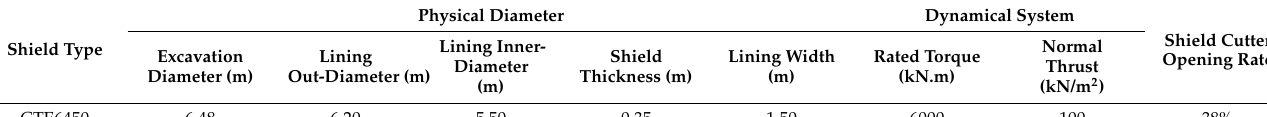
Figure 4. Front view of the EPB shield.